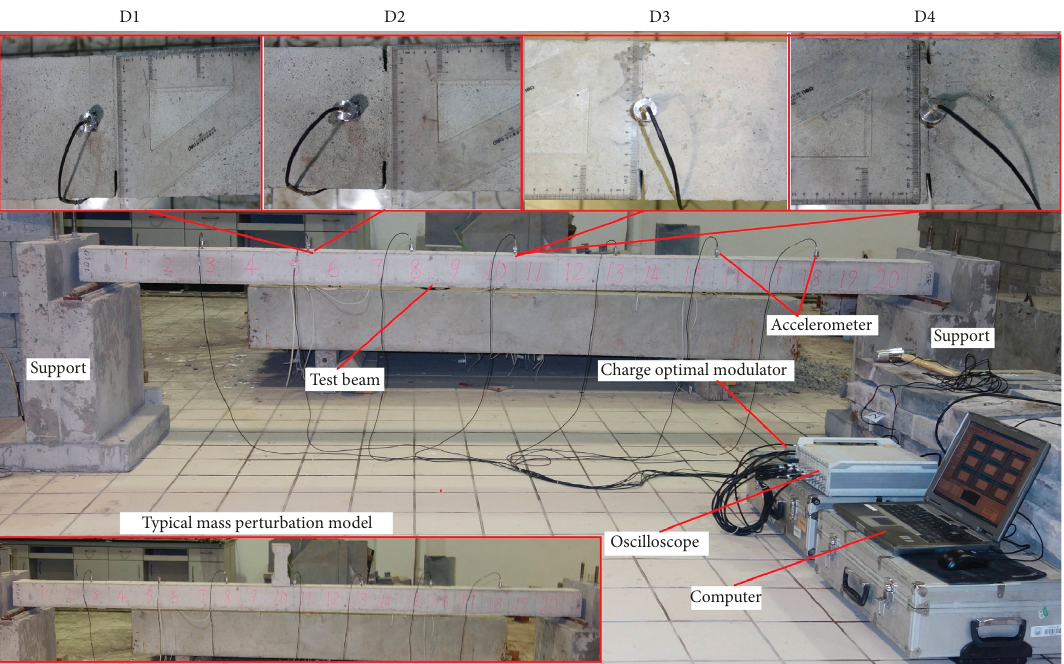
Figure 3: Modal test for RC test